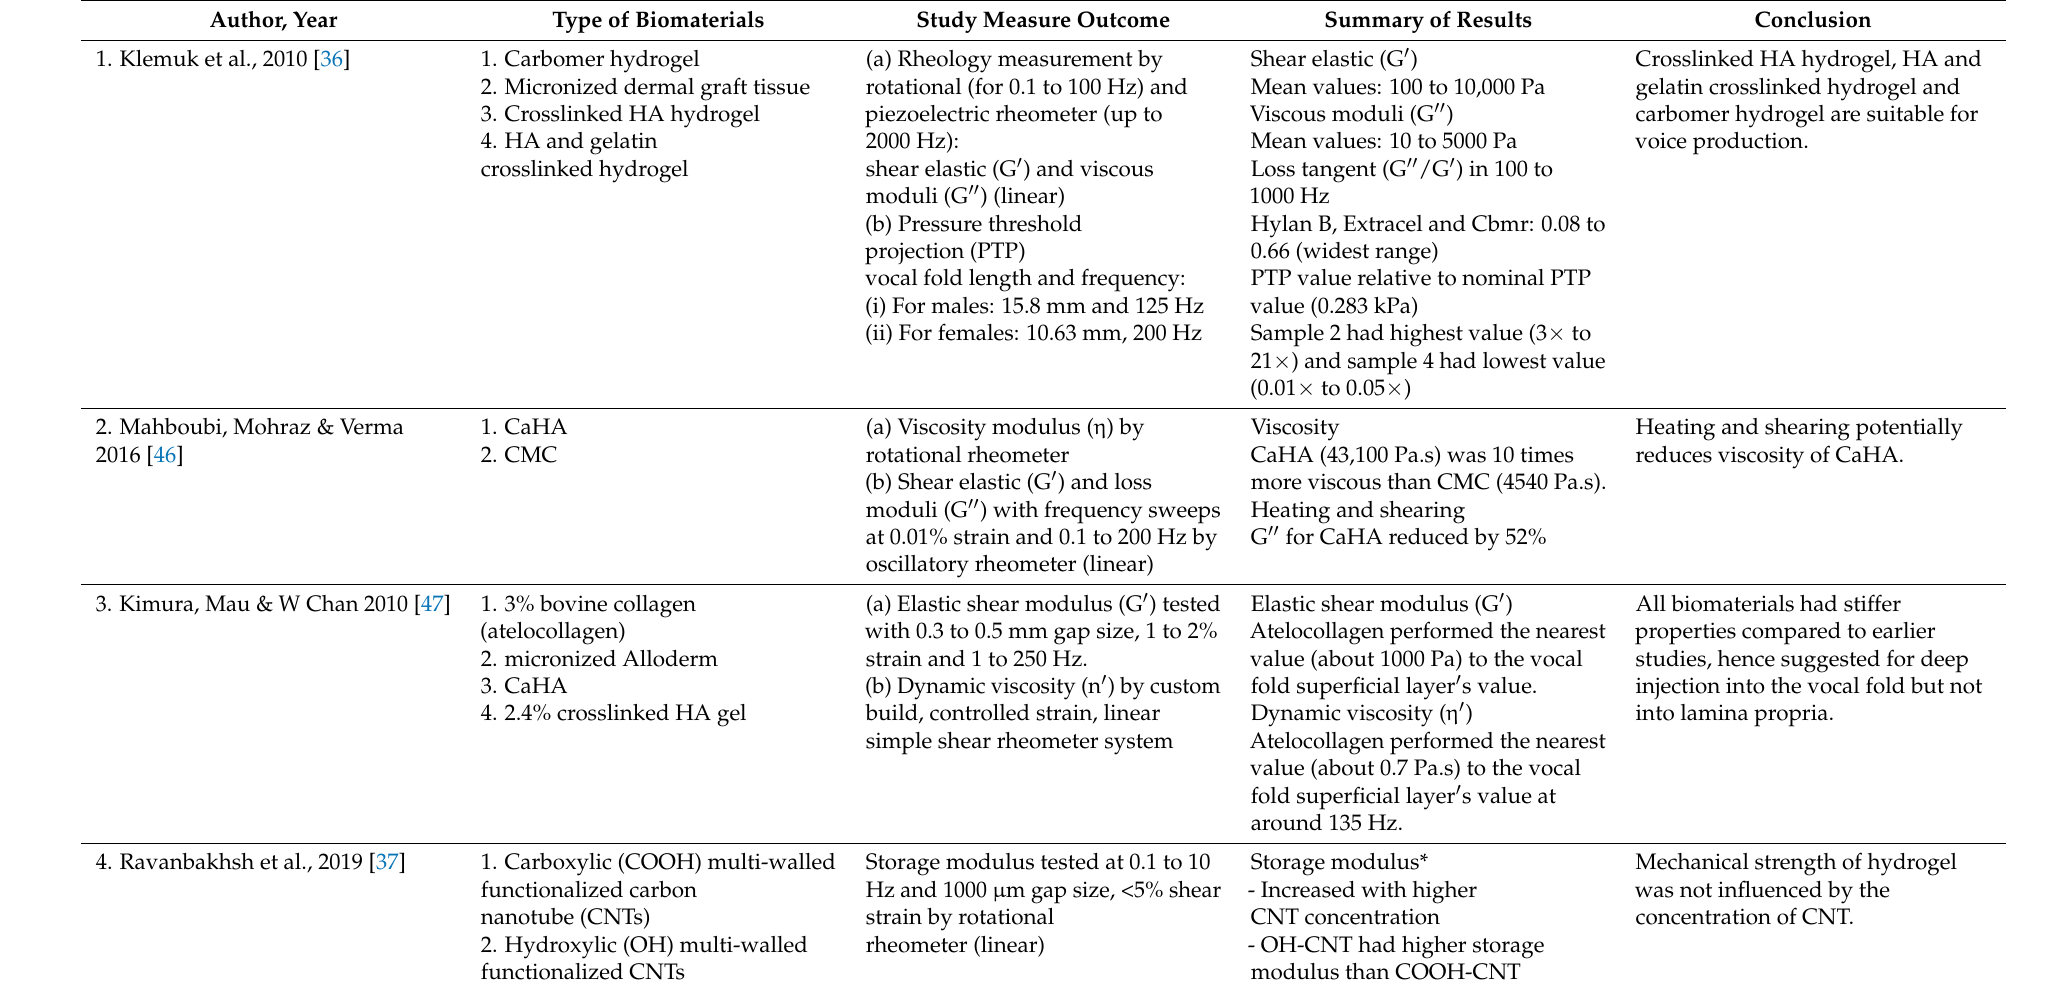
Table 2. Rheological